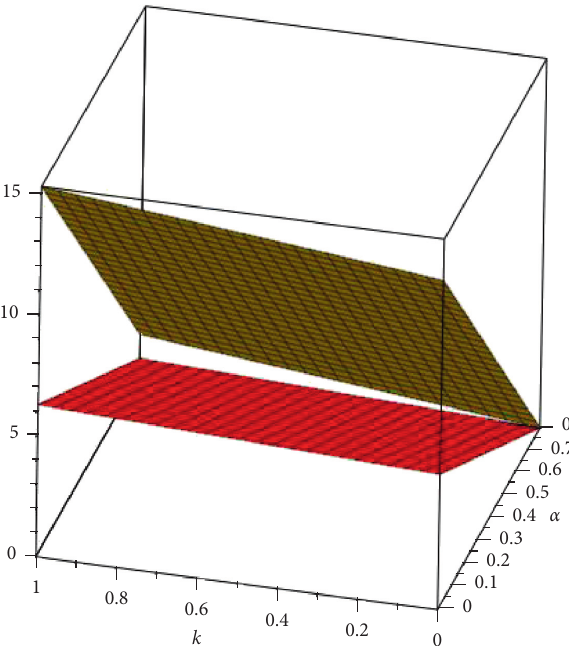
Figure 9: S index of two TraIFNs 􏽥 A and 􏽥 B . α ,k